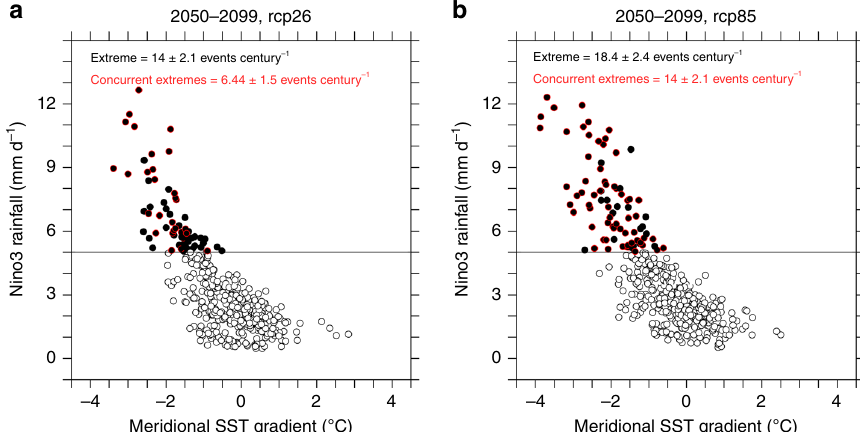
Fig. 5 Future changes in climate extremes under different emission scenarios. The plots shown are based on nine CMIP5 models which can generate both extreme pIOD 3 and extreme El Niño 23 events under the RCP2.6 emission scenario, over the time period from 2050 to 2099, focusing on boreal winter (DJF) seasons when El Niño events mature. The black dots indicate extreme El Niño events; the black dot with red outline indicates an extreme El Niño preceded by an extreme pIOD event in the same year, similar to 1997. a , b Occurrences under the RCP2.6 and RCP8.5 scenario, respectively. The difference in the two emission scenarios is that the GMT stabilises after 2050 under RCP2.6, but continues to increase after 2050 under RCP8.5. The frequency (events per century) is indicated in each panel, with the 90% con fi dence interval based on a Poisson distribution provided